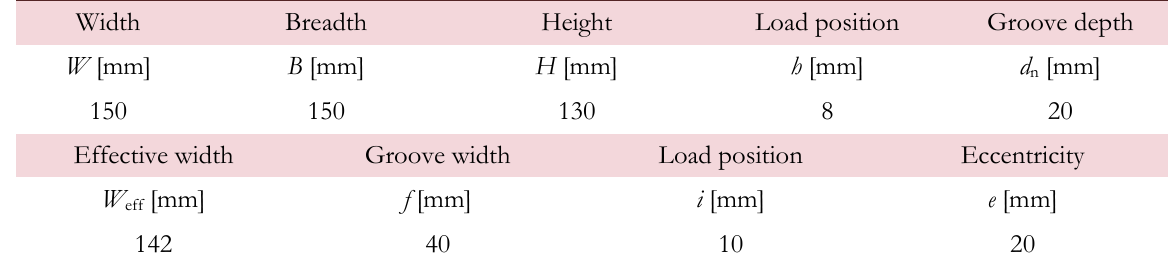
Table 1: Nominal variant dimensions and test geometry parameters, taken from [29].